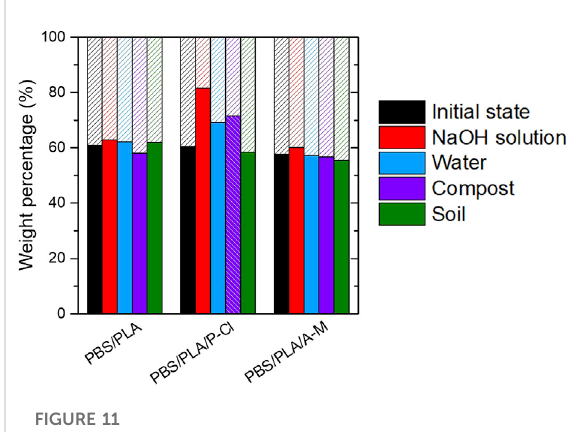
FIGURE 11 Weight proportions of PBS and PLA determined by 1H NMR titration in CDCl 3 after 3 months-degradation experiments (*except PBS/PLA/P-Cl after 2 months-composting experiment). Plain columns: PBS wt%, hatched columns: PLA